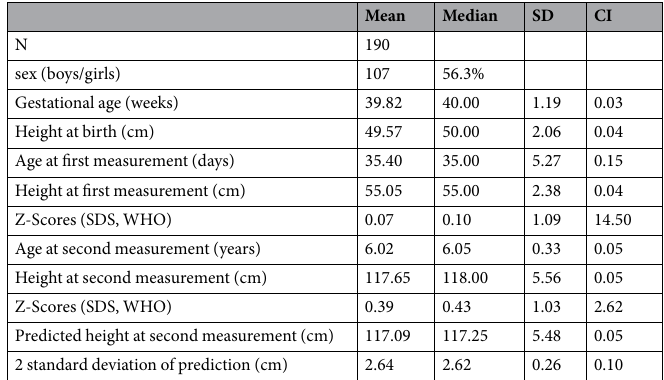
Table 1. Biometric data of the BILD cohort. Height at 6 years was predicted from length at 5 weeks of age (n = 190). SD: standard deviation, CI: confidence intervals, Z-Scores SDS: standard deviation scores from age related height based on the WHO reference values 27 .